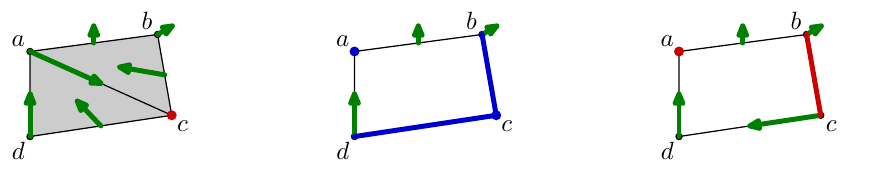
Figure 8. Discrete vector field update while removing